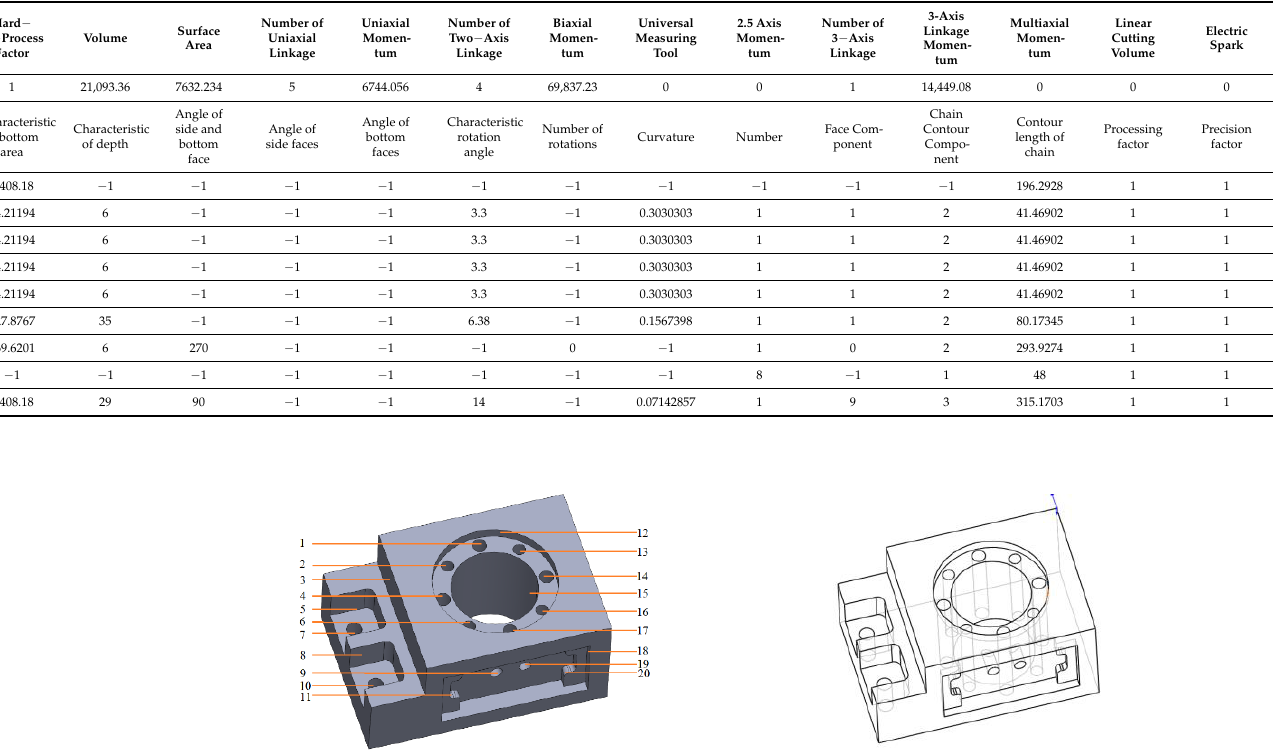
( a ) ( b ) Figure 9. ( a ) and ( b ) show feature recognition results based on syntactic pattern recognition.